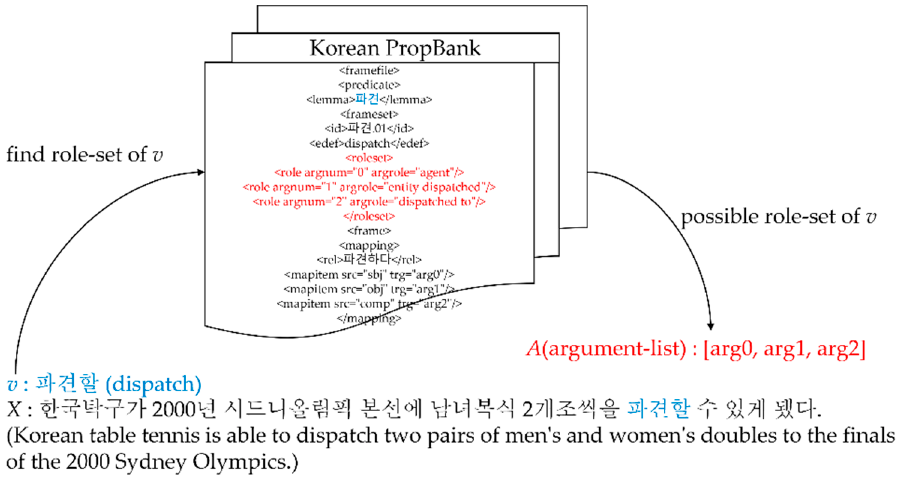
Figure 2. Example of finding an